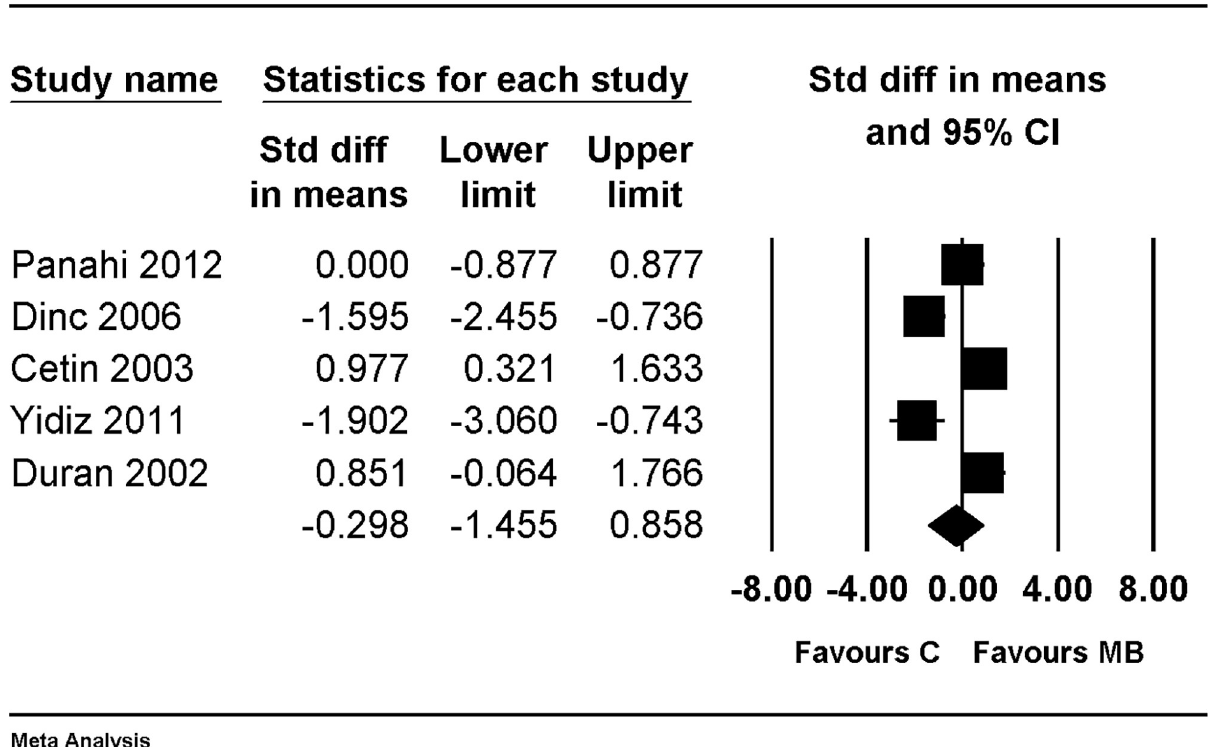
Fig 6. Forest plot showing an overall effect of macroscopic adhesion score compared with results of using nothing as control. The figure depicts individual trials as filled squares with relative sample size and the 95% confidence interval (CI) of the difference as a solid line. The diamond shape indicates the pooled estimate and uncertainty for the combined